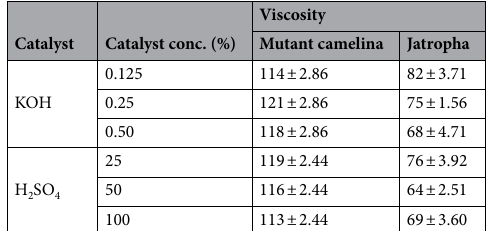
Catalyst Catalyst conc. (%)